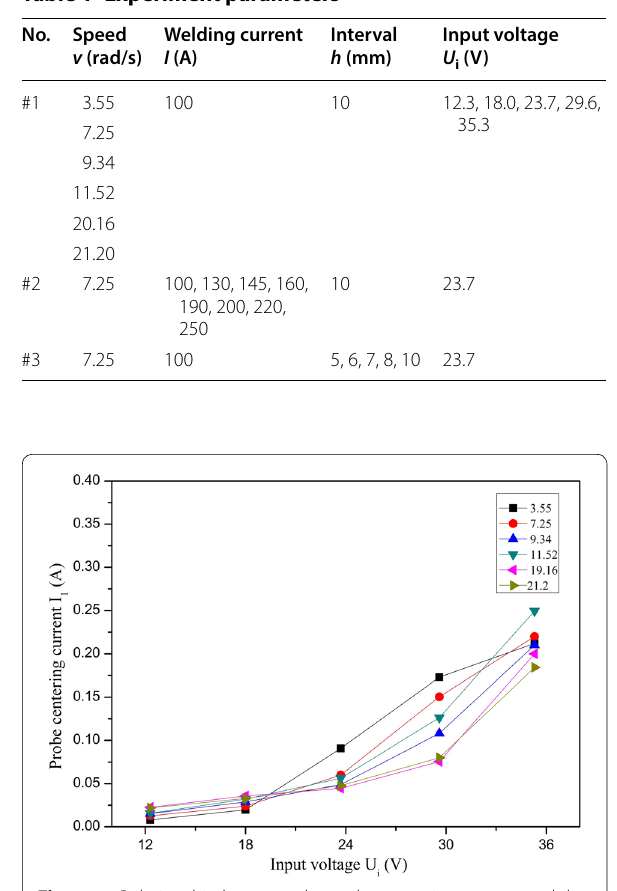
Figure 7 Relationship between the probe centering current and the input voltage at different probe speeds